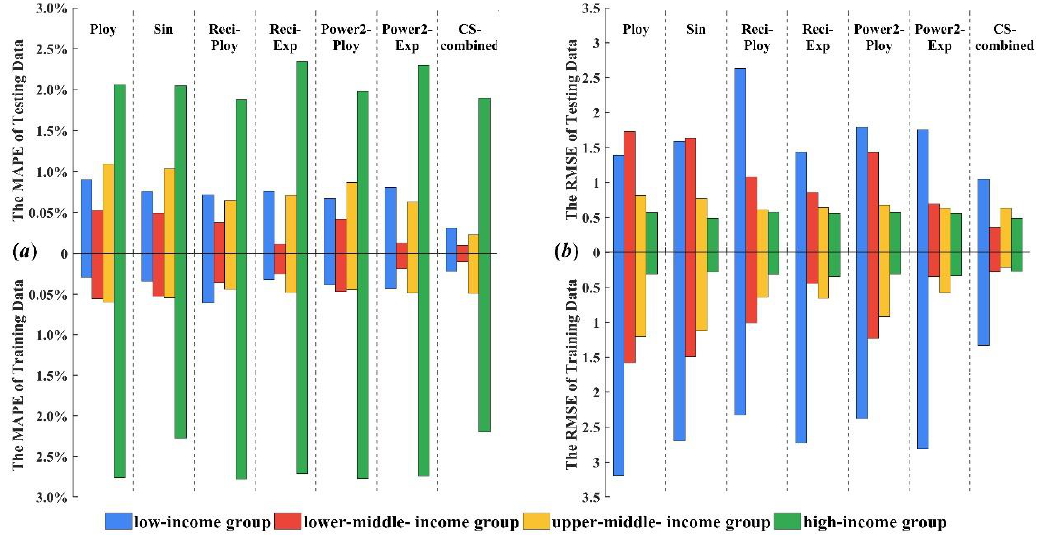
Figure 2. Stack bars of forecast errors for the four income groups.